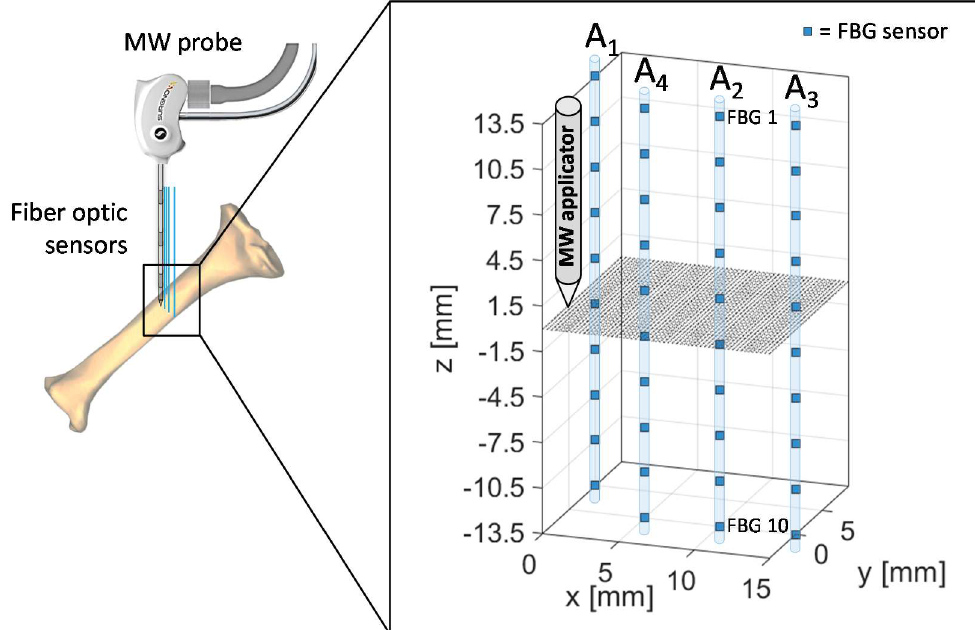
Figure 3. Schematic of FBGs and antenna positioning during the MWA procedure in the meta- Figure3. SchematicofFBGsand antennapositioningduringtheMWA procedureinthemeta-diaphyseal diaphyseal part of a bovine tibia. Antenna tip represents the origin of the coordinate system. part of a bovine tibia. Antenna tip represents the origin of the coordinate